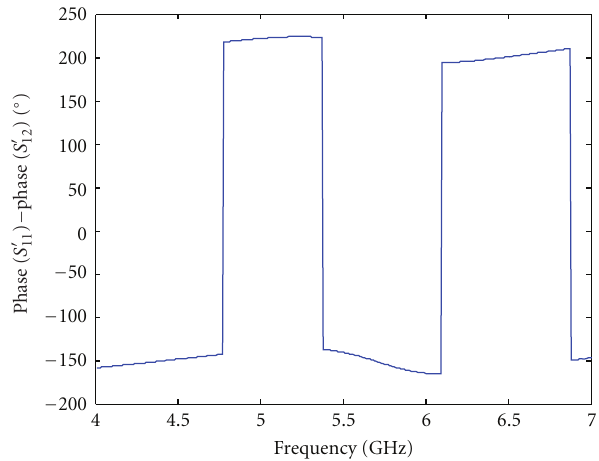
Figure 6: Calculated phase di ff erences between S (cid:2) 11 and S (cid:2) 12 of array no. 1.